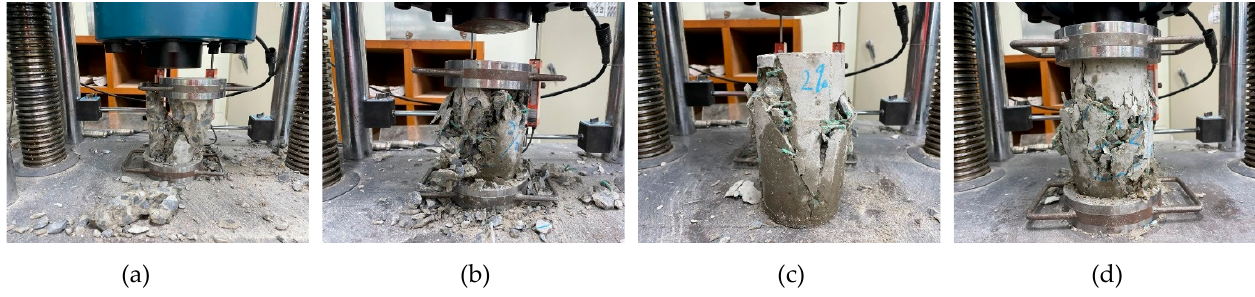
Figure 6. Failed cylindrical concrete samples in compressive strength test: ( a ) Plain concrete; ( b ) 1% WFN fiber-reinforced concrete; ( c ) 2% WFN fiber-reinforced concrete; ( d ) 3% WFN fiber-reinforced concrete. Table 6. Compressive strength test and splitting tensile strength test results.